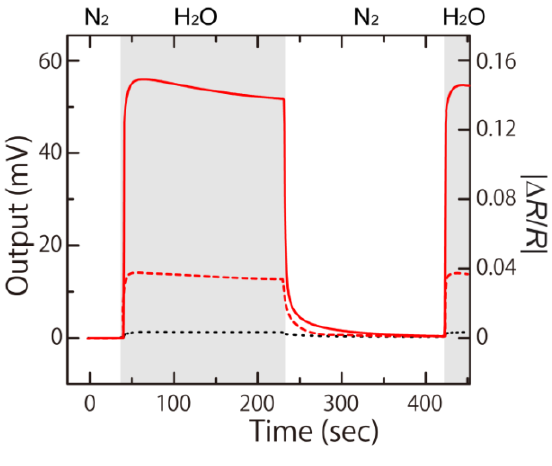
) from the 2G-MSS chip (red solid line), 1G-MSS Figure 9. Obtained output signals ( V out chip (red dashed line), and standard piezoresistive cantilever (black dotted